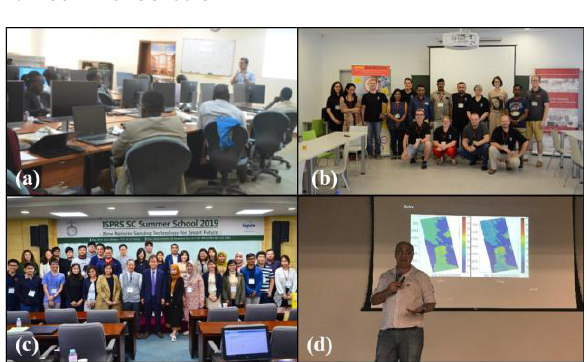
Figure 2. The summer schools held in (a) Uganda, (b) Poland, (c) South Korea and (d) Brazil in 2019.